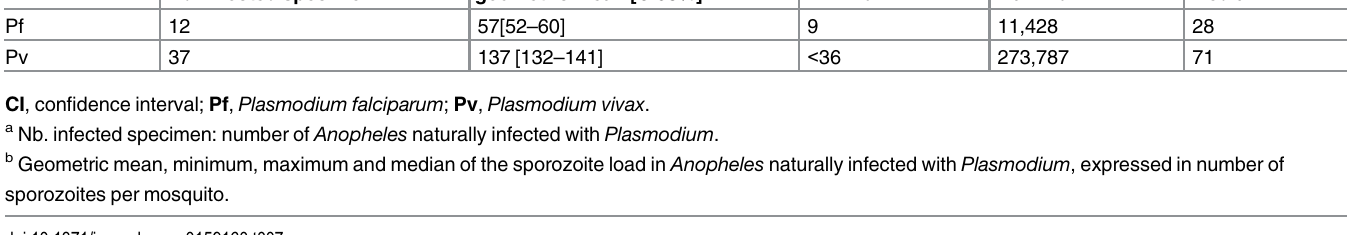
than those used to detect Plasmodium in routine samples. The dilution series must be per- formed using appropriate Plasmodium standards (Pf and Pv sporozoites) and appropriate neg- ative DNA matrix (DNA extracted from uninfected Anopheles ). Finally the quantification of the sporozoite load (expressed as a total number of sporozoites per mosquito) must be per- formed without the use of a calibrator to normalize the signal. In our study, the sporozoite loads of naturally infected Anopheles collected along the Thai- Myanmar border were very low (60% of the Anopheles carried less than < 100 sporozoites). This is consistent with previous report in the area [42] and contrasts with the high sporozoite loads observed in African malaria vectors [43 – 45]. Interestingly our findings showed a lower sporozoite load in Pf infected mosquitoes compared to Pv infected mosquitoes (geometric means of 57 CI95% [53 – 61] and 137 CI95% [132 – 141] sporozoites respectively). Baker and colleagues reported similar sporozoite loads in Pv infected malaria vectors [42] but higher Pf sporozoite density compared to our study [42, 46, 47]. These observations suggest that both the prevalence and the density of infection become low when the transmission intensity declines. Moreover the frequency distribution of the sporozoite loads seems to follow a right skewed dis- tribution, which contrasts with the log normal and unimodal distribution of parasite densities during asymptomatic malaria in the same area [48]. Therefore we suspect that the very low densities of infection observed in naturally infected malaria vectors might result from infective blood meals taken from submicroscopic gametocytæmia [49, 50]. Clearly much work has to be done to address the causal relationship between submicroscopic reservoir and malaria trans- mission along the Thai – Myanmar border. Table 7. Descriptive statistic of the sporozoite loads in naturally infected Anopheles collected along the Thai-Myanmar border. Species Value for the indicated species Nb. infected specimen a